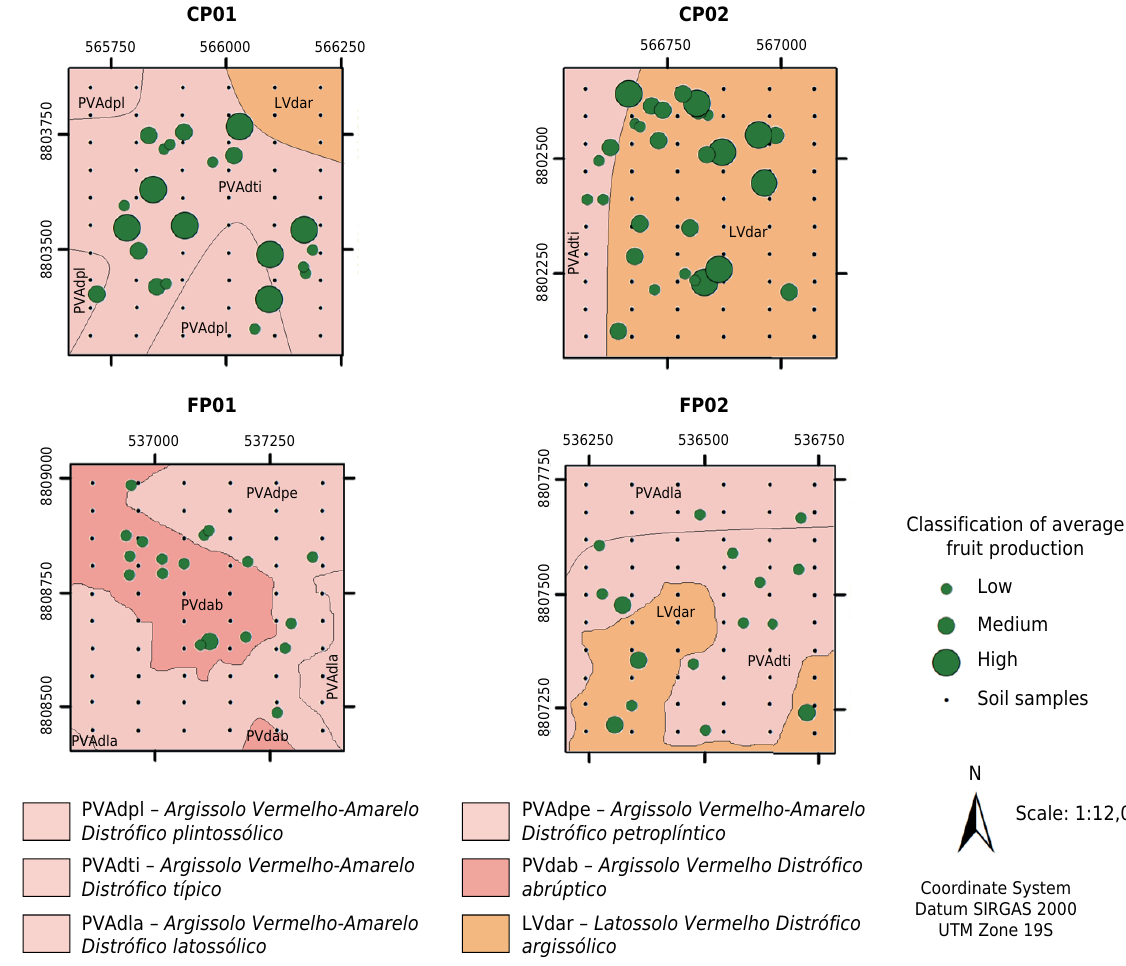
Figure 2. Map with soil profiles and average fruit production of Brazil nut trees in Cachoeira - Plots 1 and 2 (CP01 and CP02) and Filipinas - Plots 1 and 2 (FP01 and FP02). Circles on the maps correspond to the fruit production classes between the years 2010 and 2020, while points represent the locations where soil samples were collected. Source: Adapted from Bardales et al. (2011) and Ferreira et al.